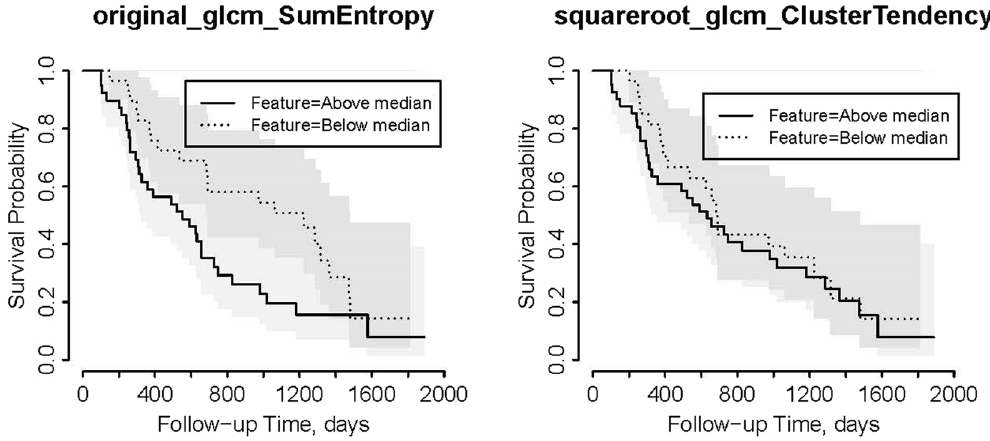
Figure 2. Kaplan-Meier plots for OS for the validation cohort with Reader 2 contours dichotomized based on the median values of significant features in the training cohort.